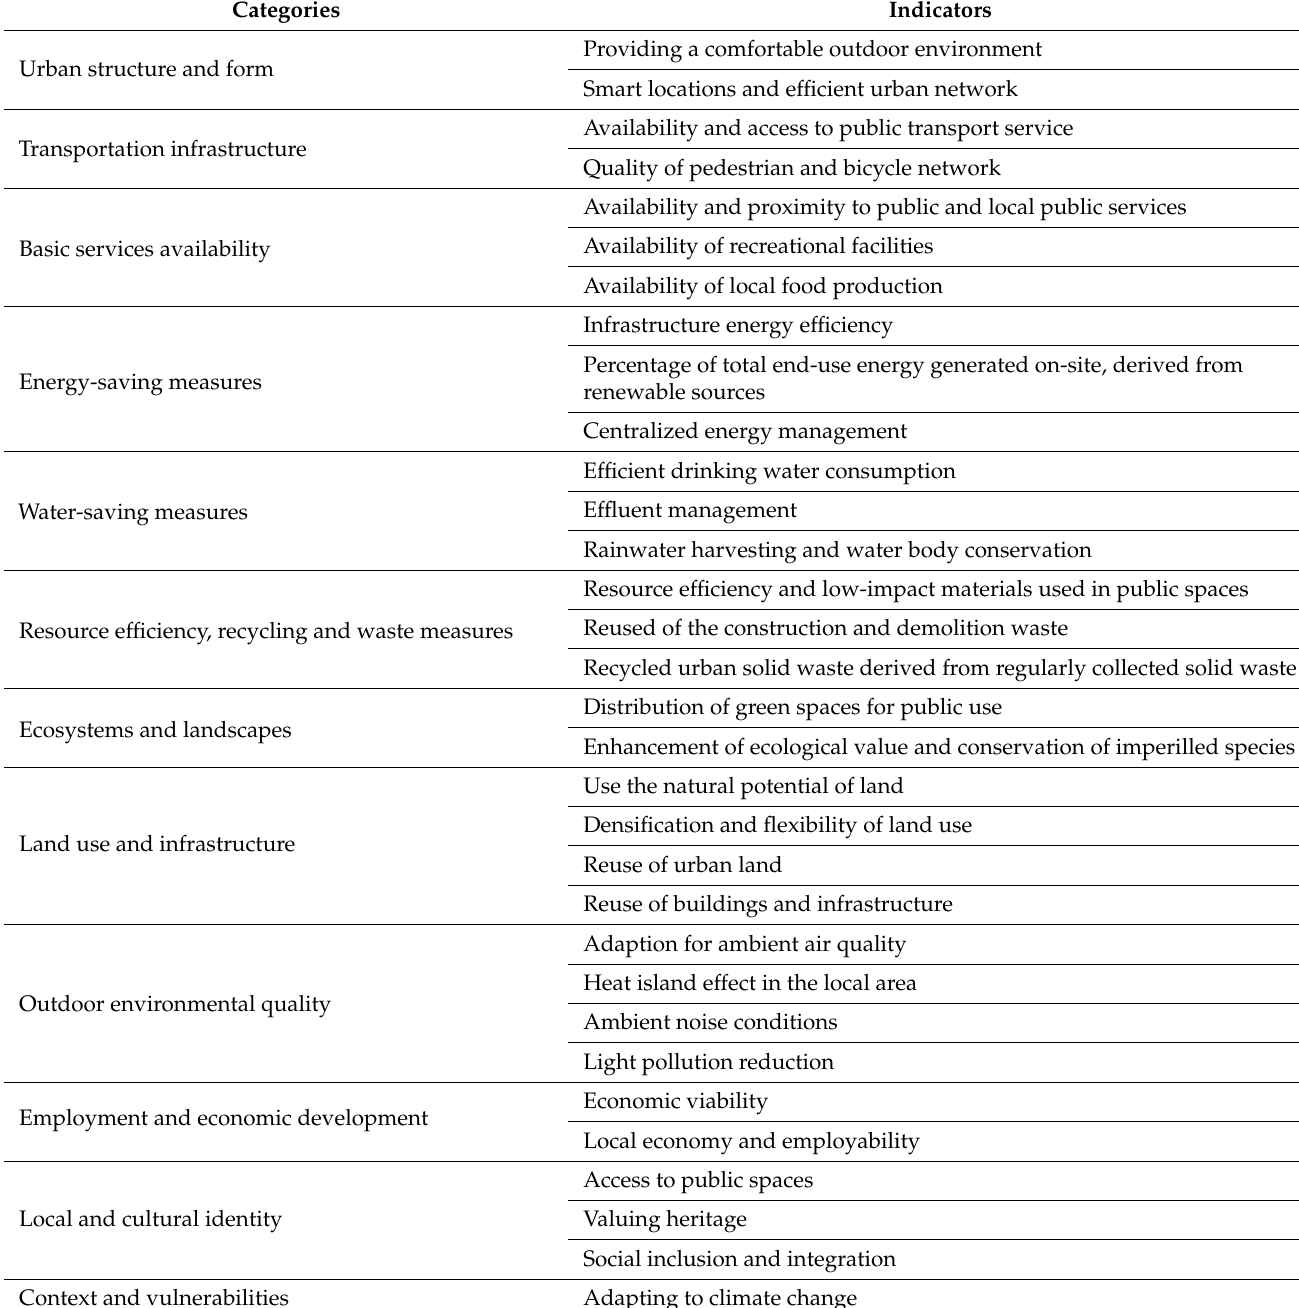
Table 3. Proposed indicators for urban sustainability assessment that can be applied in different